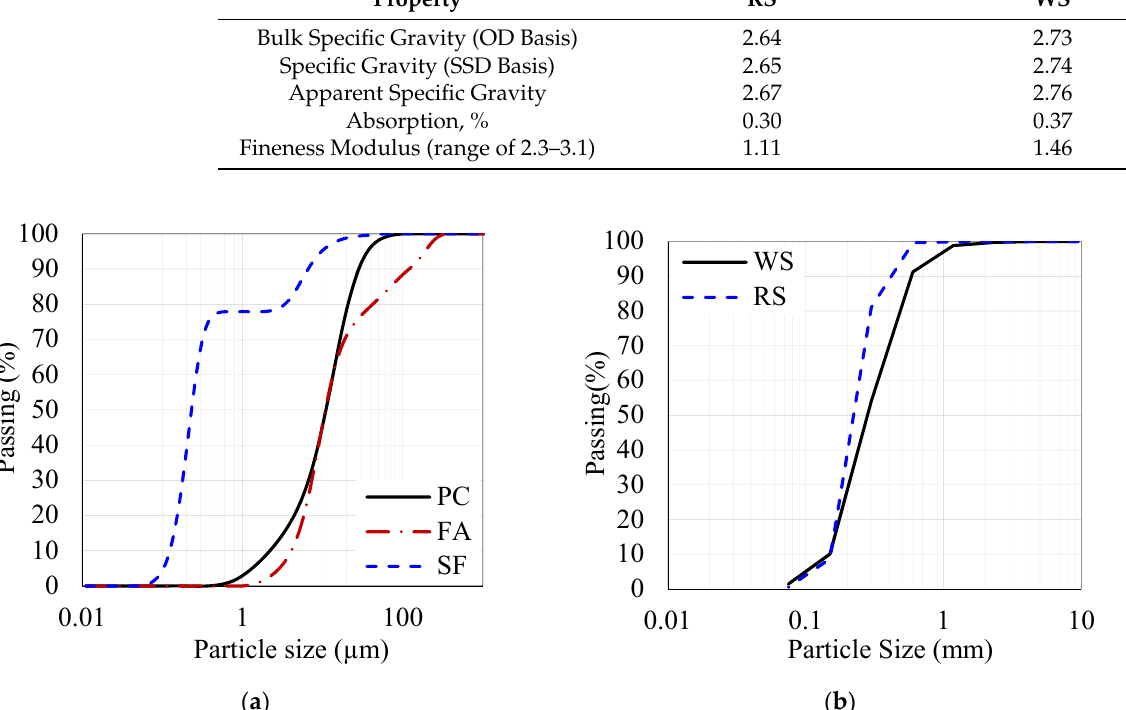
Figure 1. Grain size distribution of ( a ) types of cement and ( b )